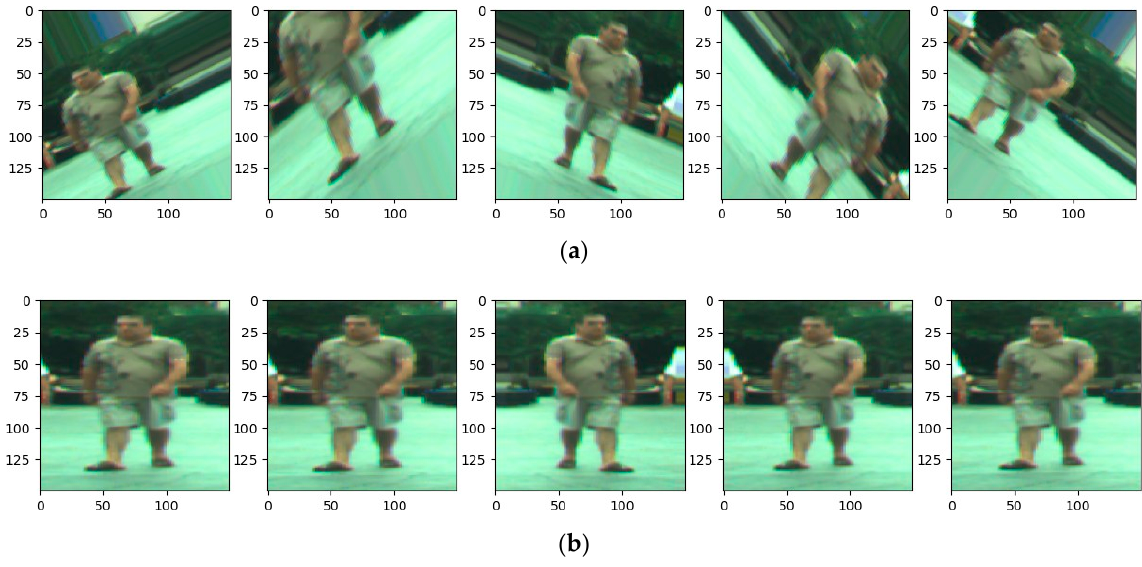
Figure 3. ( a ) Unsuitable image augmentation. ( b ) Suitable image augmentation.